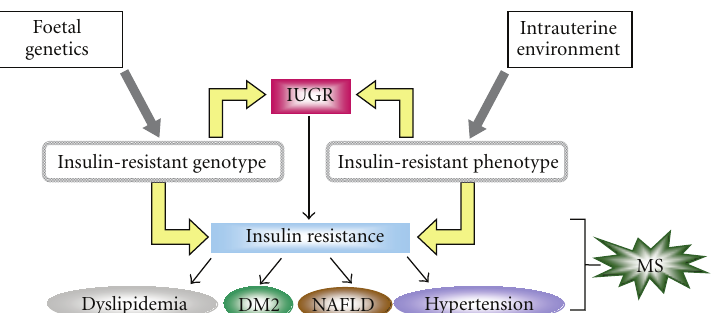
Figure 1: Possible hypotheses to explain the association between IUGR and MS. IUGR: intrauterine growth retardation; DM2: type 2 dia- betes; NAFLD: nonalcoholic fatty liver disease; MS: metabolic